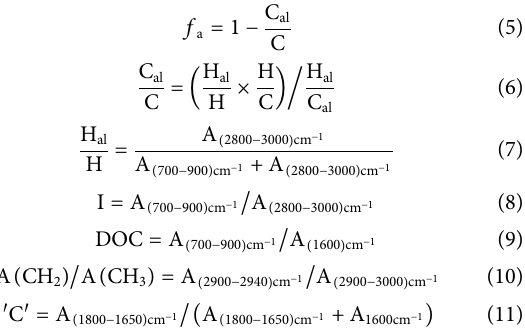
FIGURE 2 Relationship between random vitrinite re fl ectance and thermal simulation